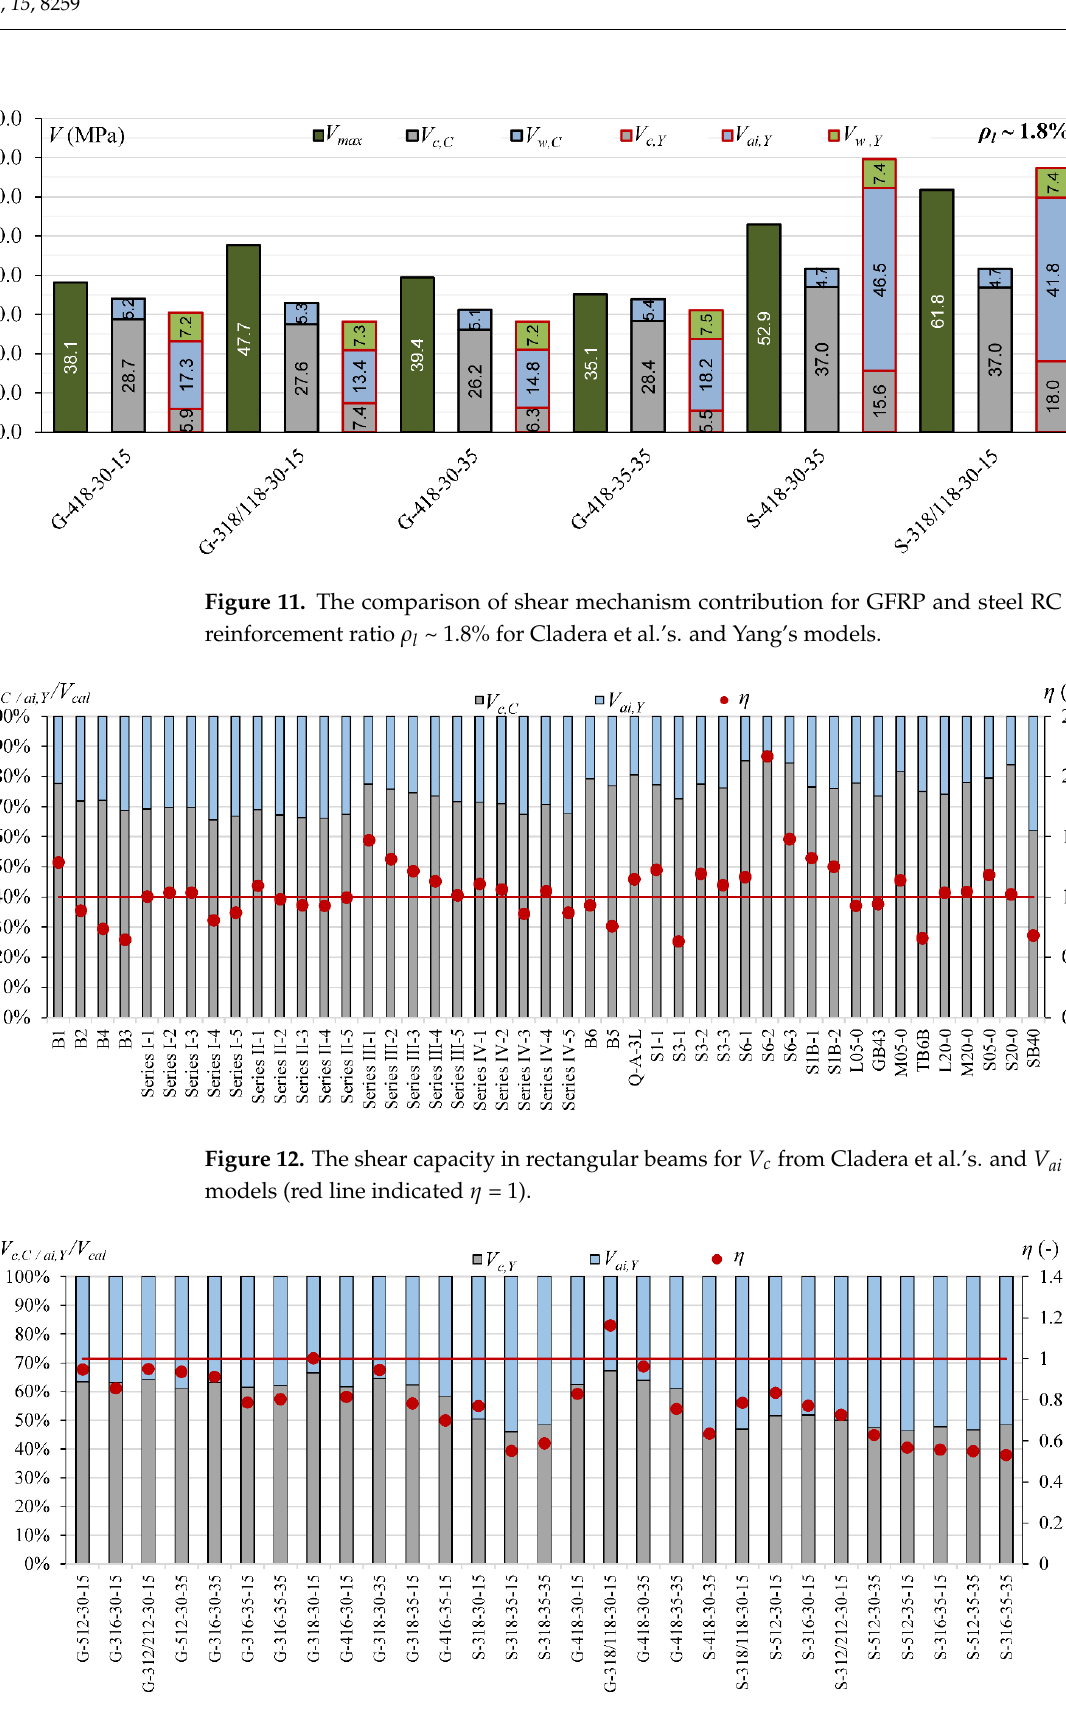
Figure 13. The shear capacity in T-section beams for V c from Cladera et al.’s. and V ai from Yang’s models (red line indicated η = 1).